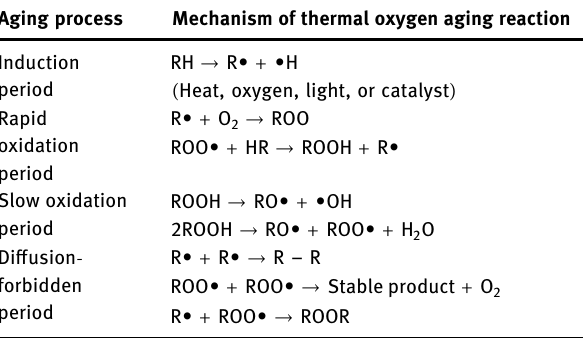
Table 2: The thermal oxygen aging reaction of rubber Aging process Mechanism of thermal oxygen aging reaction